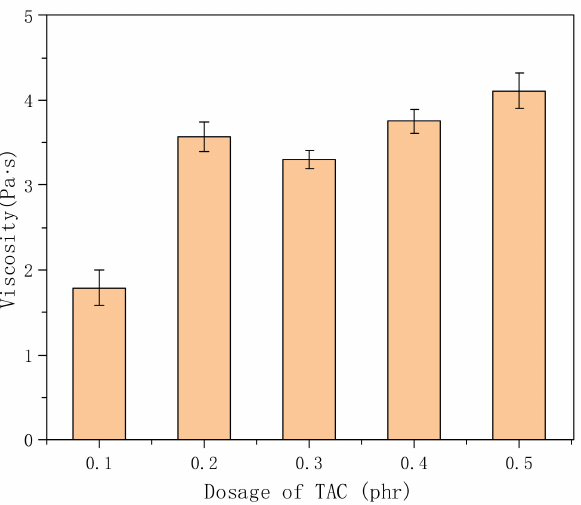
Figure 6. Effects of different amounts of crosslinking agent on the viscosity of polymer solution (concentration: 0.3%; VAc:AA =